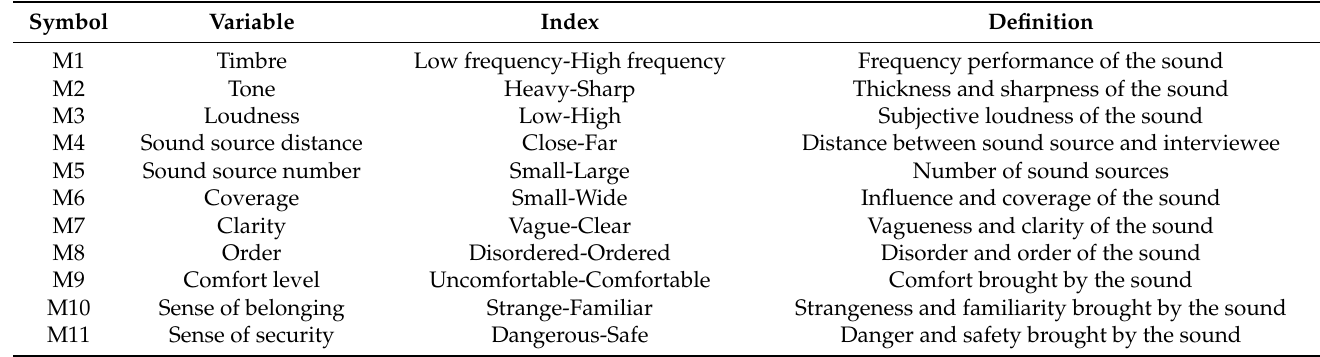
Table 3. The semantic differential